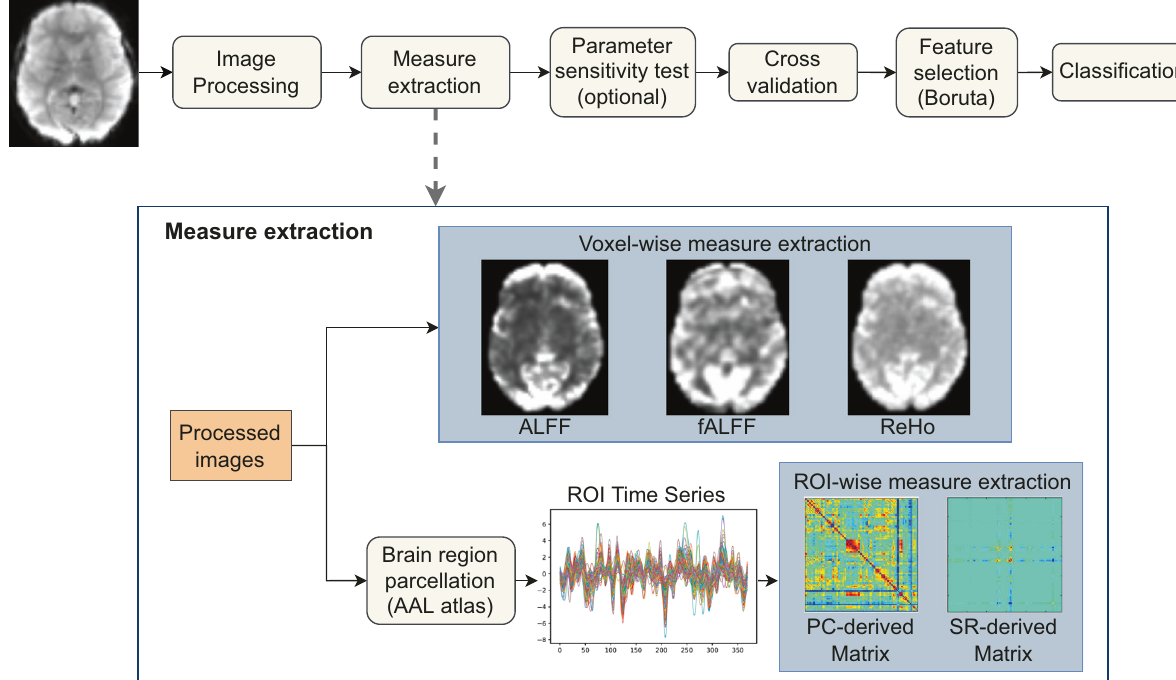
Fig. 1 The pipeline of the whole study design. ALFF amplitude of low-frequency fl uctuations, fALFF fractional ALFF, ReHo regional homogeneity, AAL automated anatomical labeling, ROI regions of interest, PC Pearson ’ s correlation, SR sparse